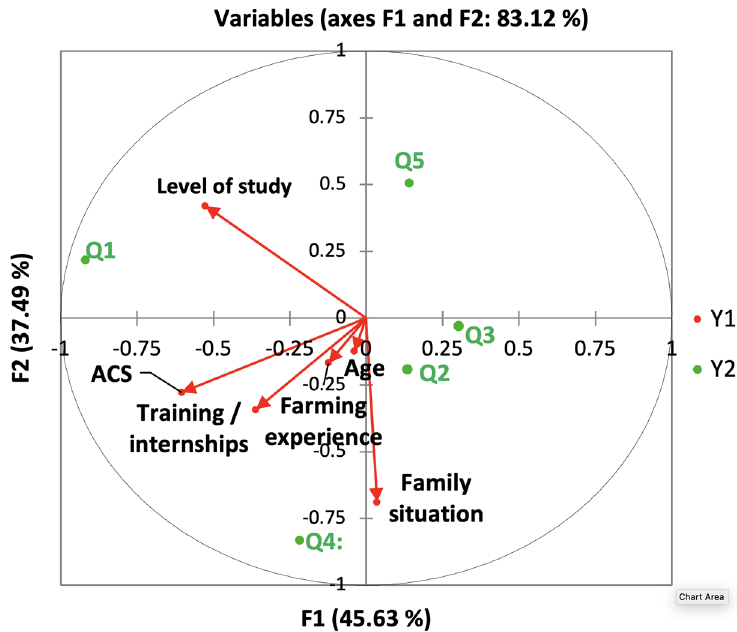
Figure 6. Biplot of perception of pesticide risks and social and demographic characteristics of inter- viewees under canonical correspondence analysis. Full questions are presented in Supplementary Materials. Q1: Do you know the pesticide residues? Q2: Do you think pesticides are harmful to hu- man health? Q3: Did you know that the environment can be affected by pesticides? Q4: Do you think that water pollution is linked to the application of pesticides? Q5: Do you know the relation- ship between pesticides and disease? ACS, benefit from agricultural advisory services. The first two canonical axes (Y1 and Y2) are in the horizontal and vertical directions. Variables of different varia- bles of personal demographic characteristics are represented by the arrows. The arrow direction indicates the correlation between each variable and the canonical axes. The arrow length shows the relative contribution of the variables to the axes and the protective behavior-personal socioeconomic characteristics relationship, this being the principle of canonical correspondence analysis.